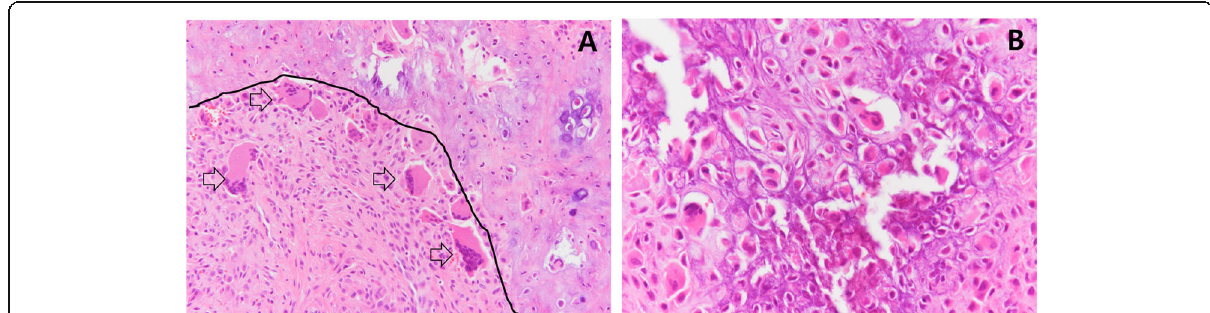
Fig. 3 A The tumor is composed of sheets of mononuclear cells (below the line) admixed with occasional multinuclear cells (arrow); hematoxylin and eosin stain, 200×. The eosinophilic and basophilic chondroid matrix (above the line) is intermingled. B The degenerative area shows